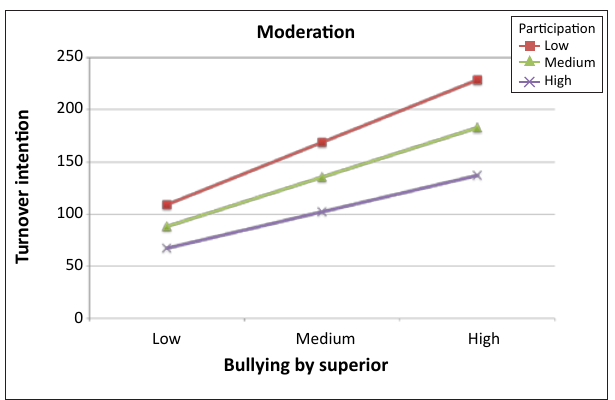
FIGURE 2: Interaction of bullying by superiors with participation in decision- making in relation to turnover